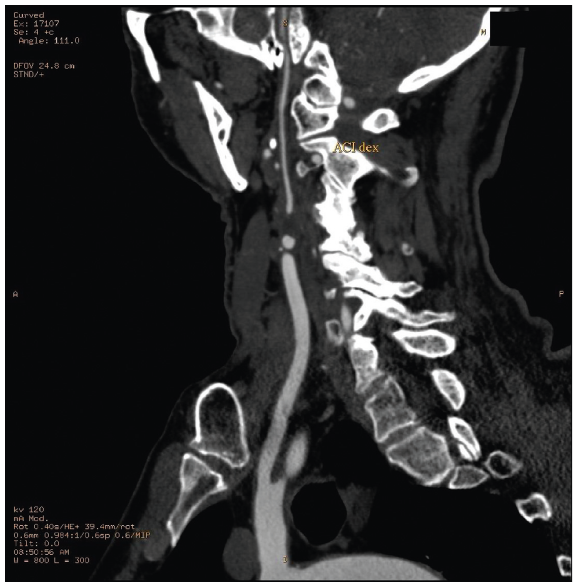
Figure 3: MDCT angiography of type II segmental ICA occlusion (multiplanar